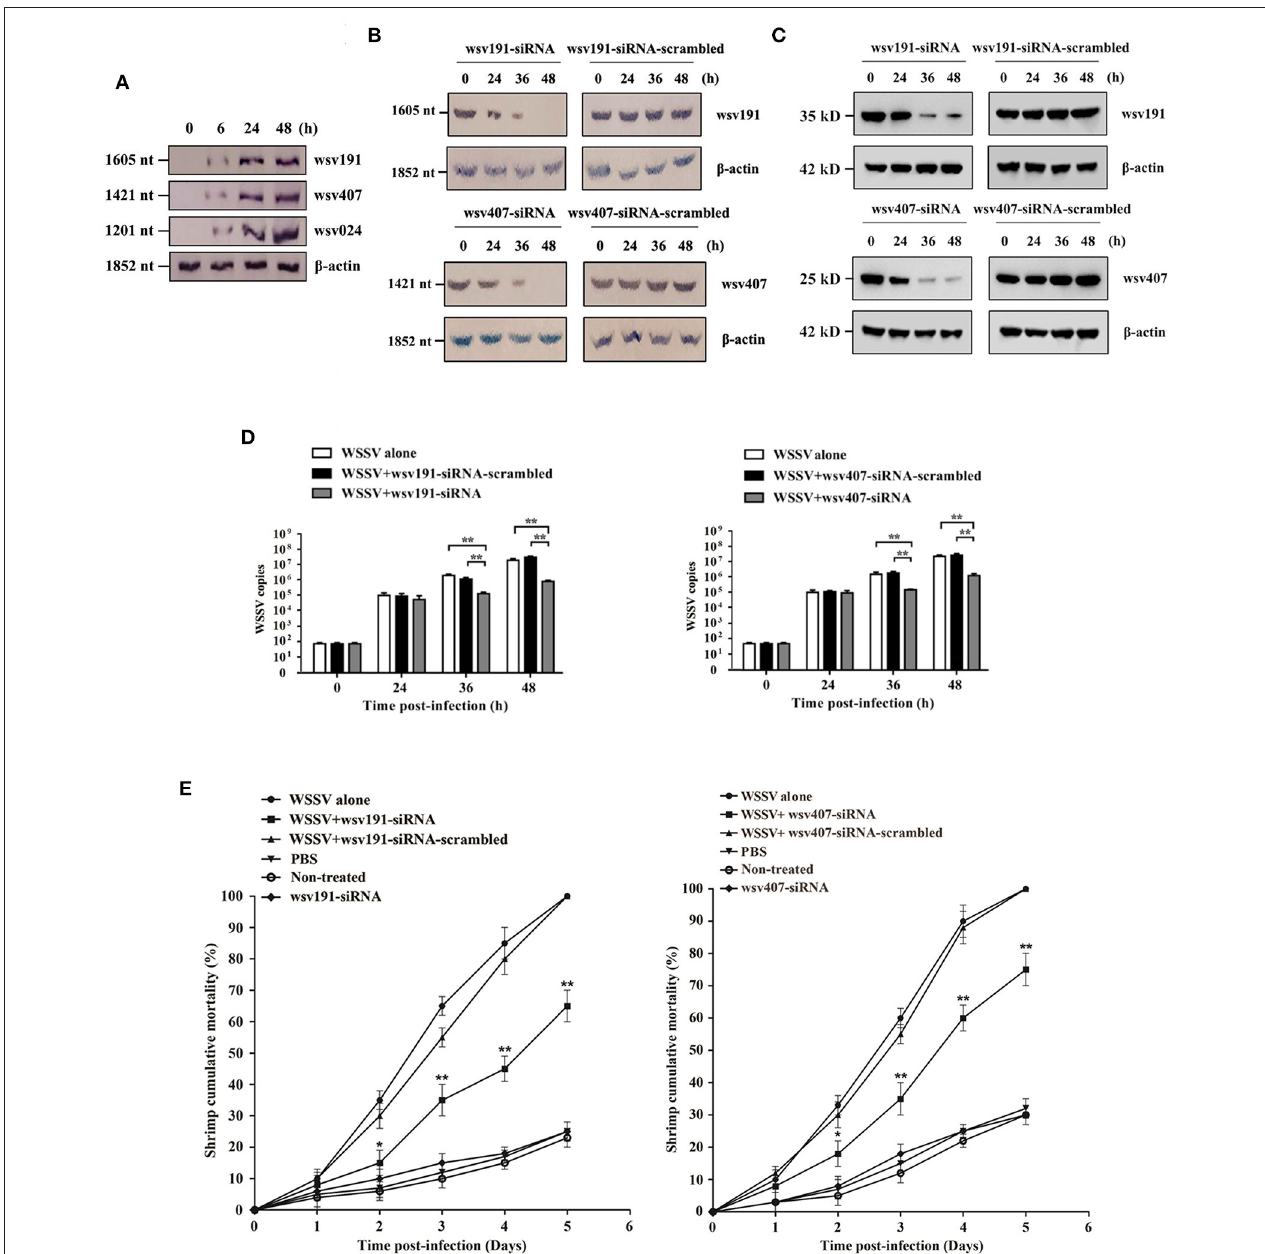
FIGURE 3 | Effects of wsv191 and wsv407 gene silencing on WSSV infection. (A) Northern blot analysis of wsv191 , wsv407, and wsv024 gene expressions in WSSV-infected shrimp. Numbers indicated the time post-infection. (B) Silencing of wsv191 and wsv407 gene expressions in shrimp. Shrimp were infected with WSSV. At 48h post-infection, shrimp were injected with wsv191-siRNA or wsv407-siRNA. Twelve hours later, shrimp were re-injected with the siRNA. At different time points after the last siRNA injection, the mRNA levels of wsv191 and wsv407 were determined using Northern blot. Numbers represented the time after the last siRNA injection of WSSV-infected shrimp. (C) Western blots showing the silencing of wsv191 and wsv407 in shrimp in vivo . (D) Influence of wsv191 and wsv407 gene silencing on WSSV virus infection in shrimp. Shrimp hemocytes were subjected to quantitative real-time PCR to determine WSSV copies. (E) Effects of wsv191 and wsv407 silencing on shrimp mortality. The mortality of shrimp per different treatment groups was examined daily. The treatments were shown on the top. Significant statistical differences between treatments were indicated with asterisks (* p < 0.05; ** p < 0.01).